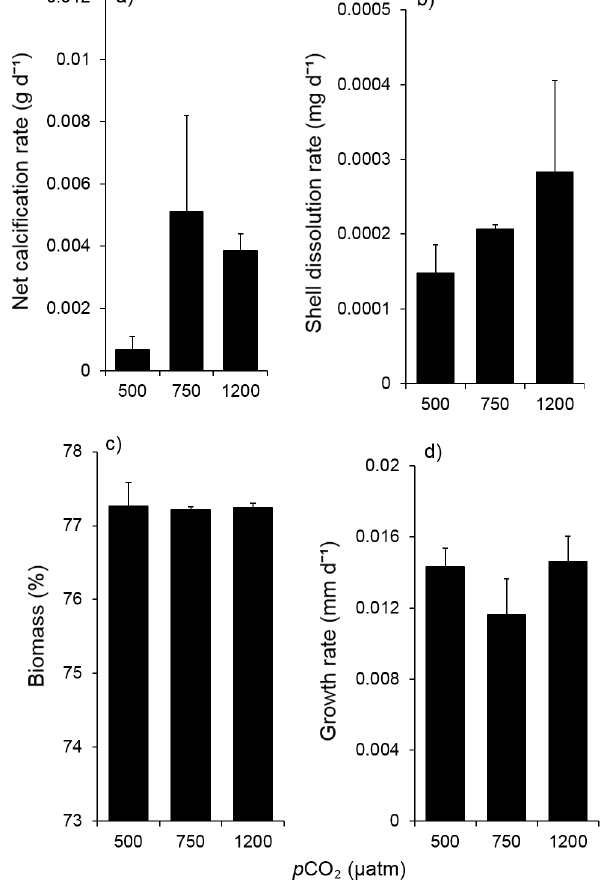
Fig. 3. (a) Net calcification, (b) shell dissolution rates, (c) bio- mass, and (d) growth rates of the mussel Choromytilus chorus exposed to contrasting p CO 2 levels. Bars correspond to means ±1 SE